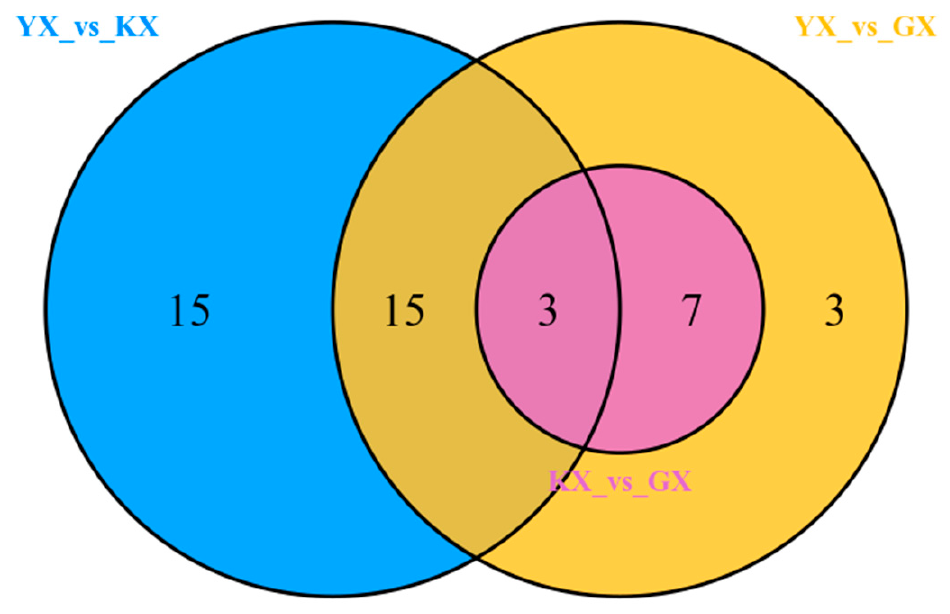
Figure 5. Venn diagram of differential metabolites in comparative analysis of three groups. YX_vs_KX represents those differential metabolites between YX and KX; YX_vs_GX represents those differential metabolites between YX and GX; KX_vs_GX represents those differential metabolites between KX and